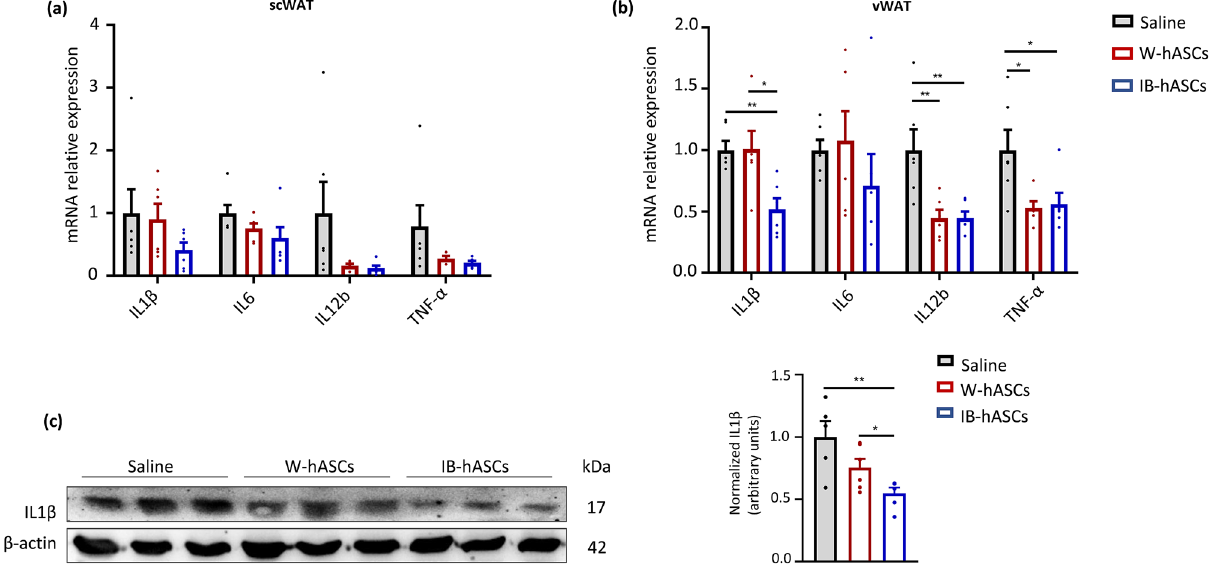
Figure 4. Infusion of IB-hASCs ameliorates adipose tissue inflammation. ( a ) Mean mRNA expression levels of pro-inflammatory cytokines in scWAT and ( b ) vWAT (n = 6). ( c ) Representative western blot analysis for IL1ß and β-actin in vWAT (n = 5 for saline; n = 6 for W-hASCs and IB-hASCs). Data are shown as mean ± s.e.m. * P < 0.05, ** P < 0.01 (one-way